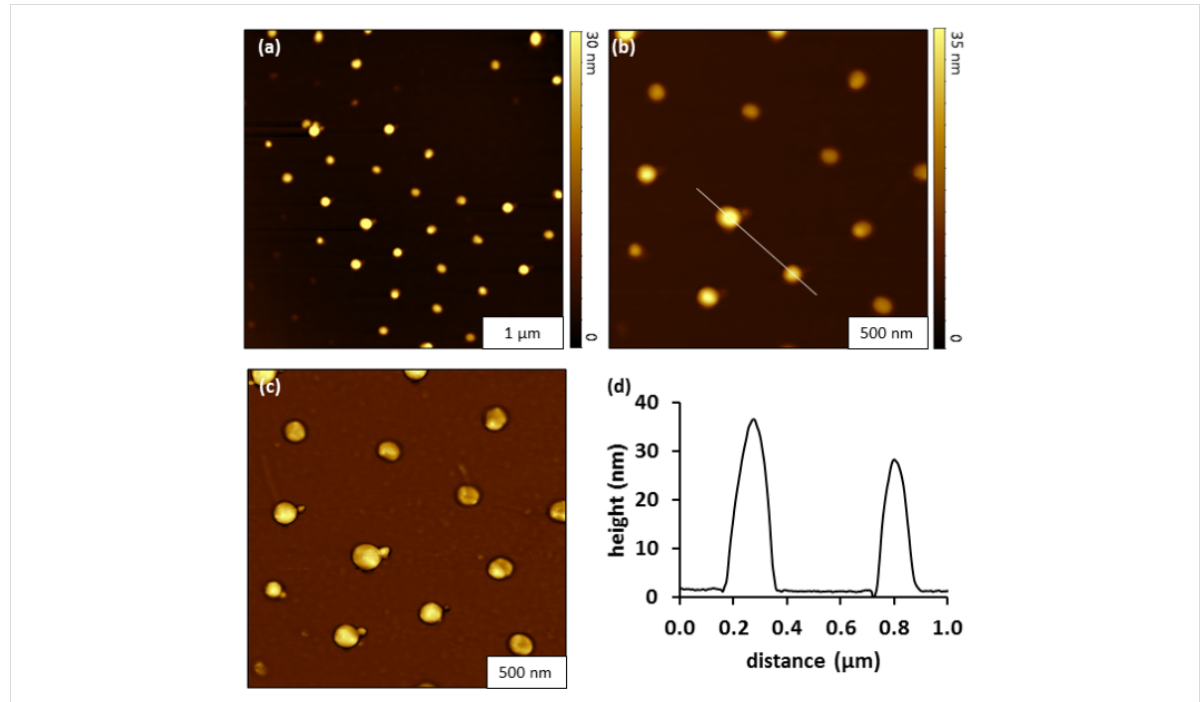
Figure 4: Heterostructures comprised of CMPS and H 2 TPyP porphyrin grown on Si(111) in BCH. (a) Topography image (4 × 4 μ m 2 ) of porphyrin nanostructures grown on CMPS nanodots. (b) Zoom-in topography view of porphyrin heterostructures; (c) simultaneously acquired phase image; (d) cursor profile for the line in